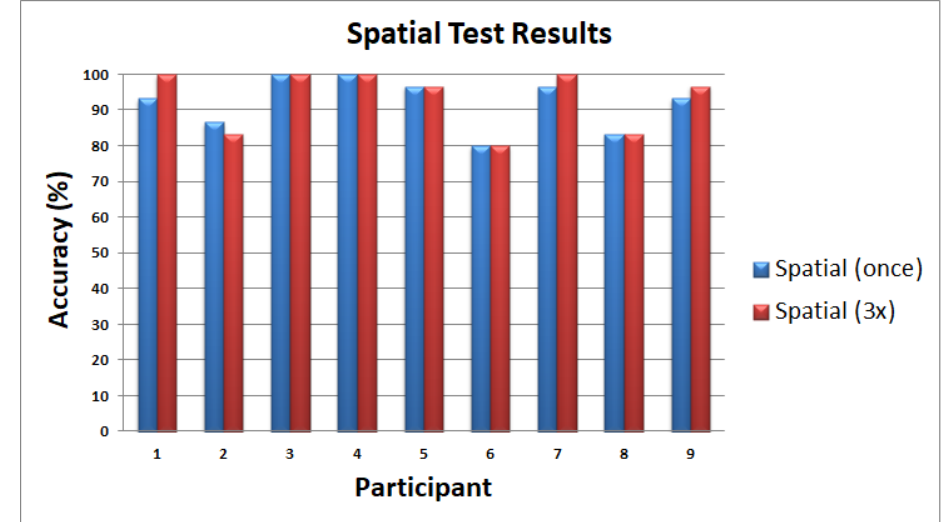
Figure 23. Spatial Test Results.